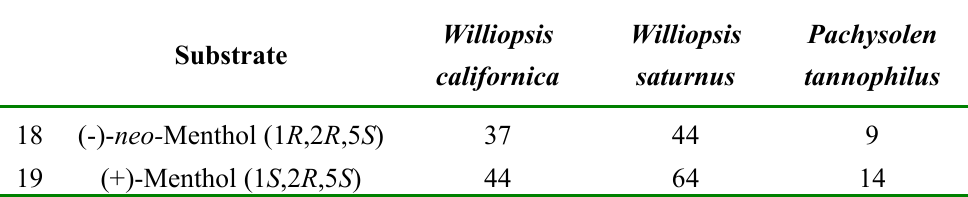
Table 6. Oxidation of menthol and neo- menthol using the selected strains for oxidation of